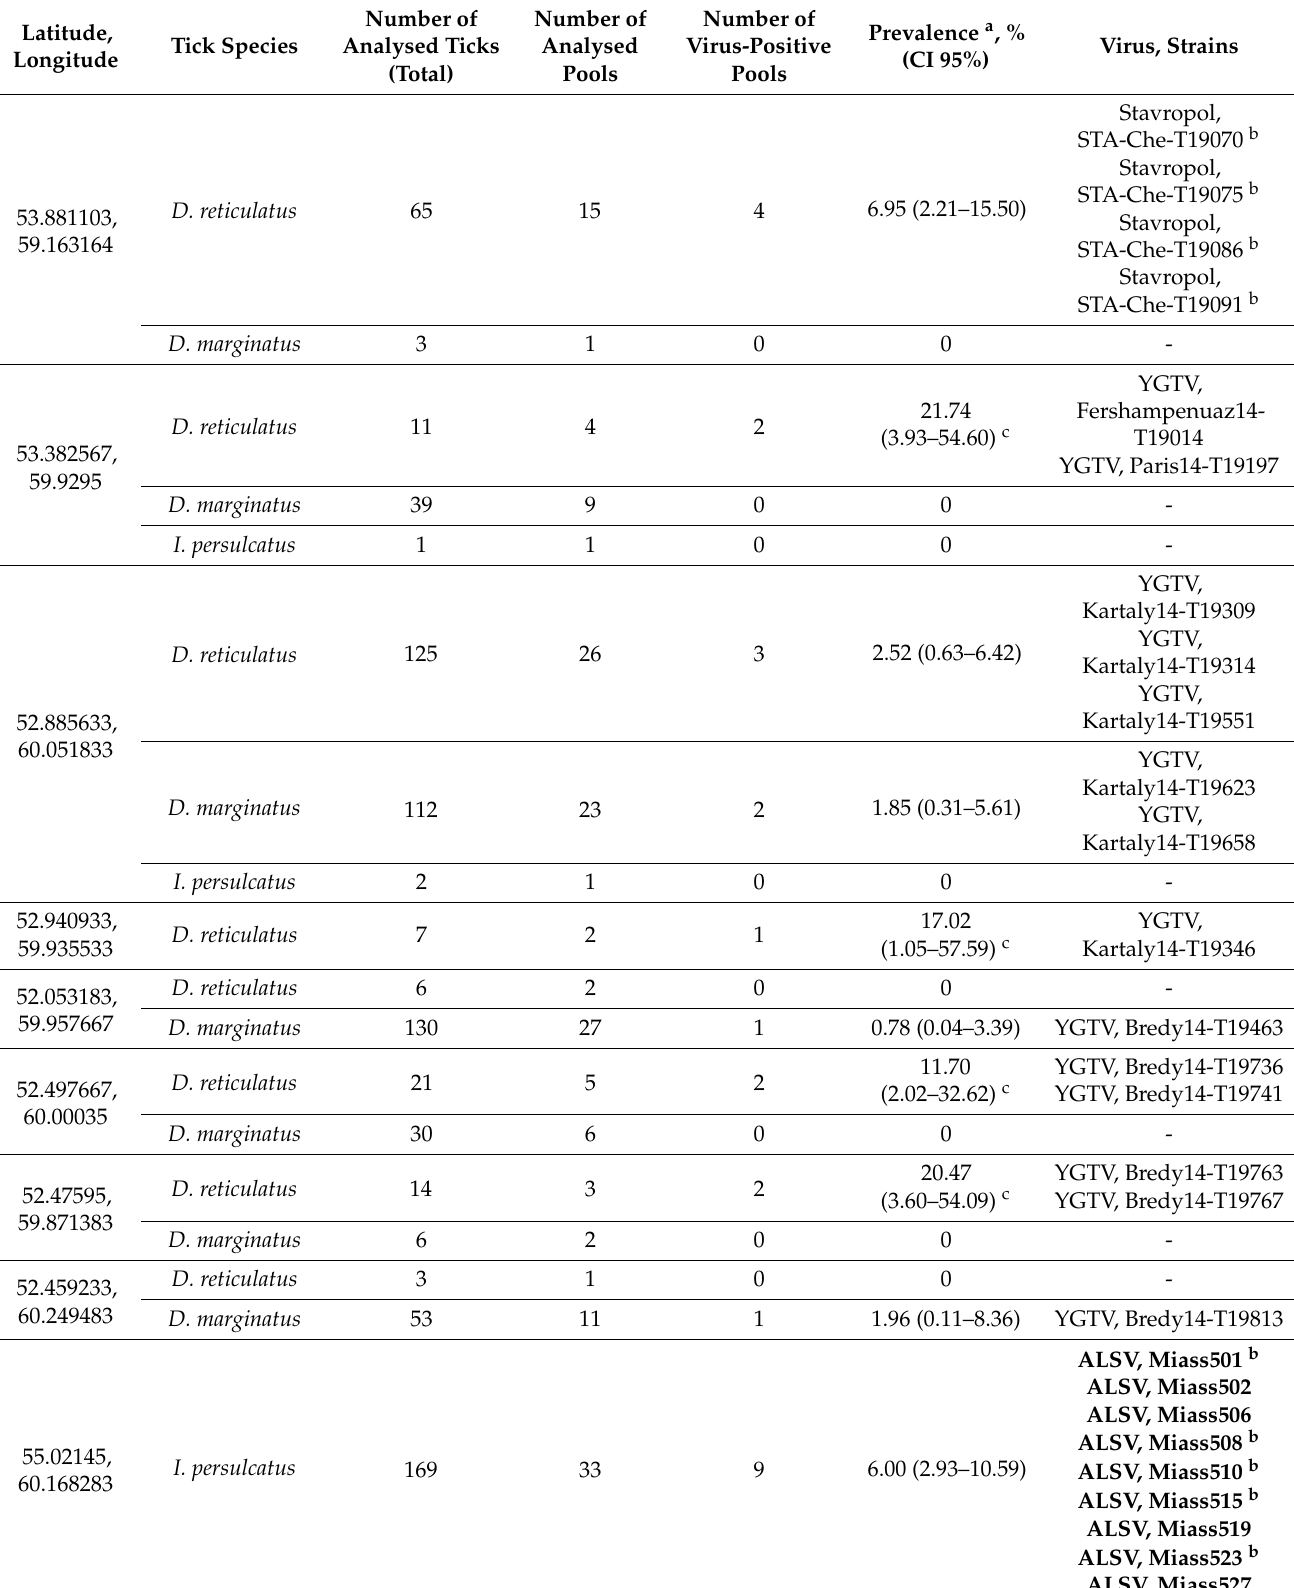
Table 1. Prevalence of the TBEV, flavi-like, and phenuiviruses in ticks in the Chelyabinsk region in the years 2014–2015 a